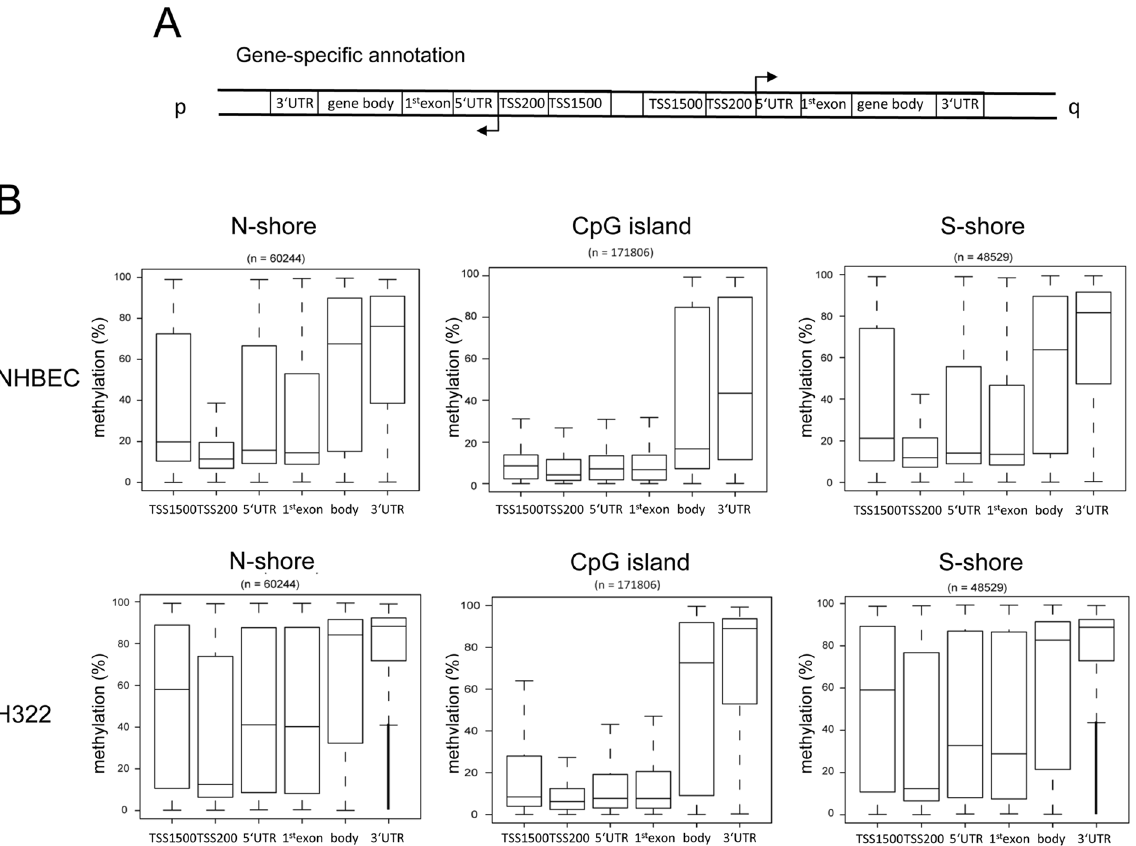
Figure 2. Methylation of gene specific CpGs in lung cancer cell lines. ( A ) CpG sites are annotated depending on the gene specific orientation in TSS1500 ( − 1500 to − 200 bp), TSS200 ( − 200 bp to TSS), 5 ′ -UTR, 1 st exon, gene body and 3 ′ -UTR. ( B ) Methylation levels of CpG islands and flanking N-and S-shores were analyzed in NHBEC and in the lung cancer cell line H322 by 450 K bisulfite bead chip arrays according to the gene specific